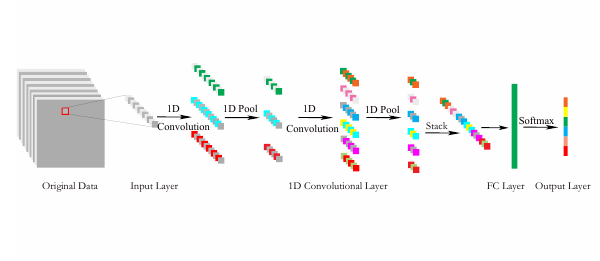
Figure 1. The architecture of